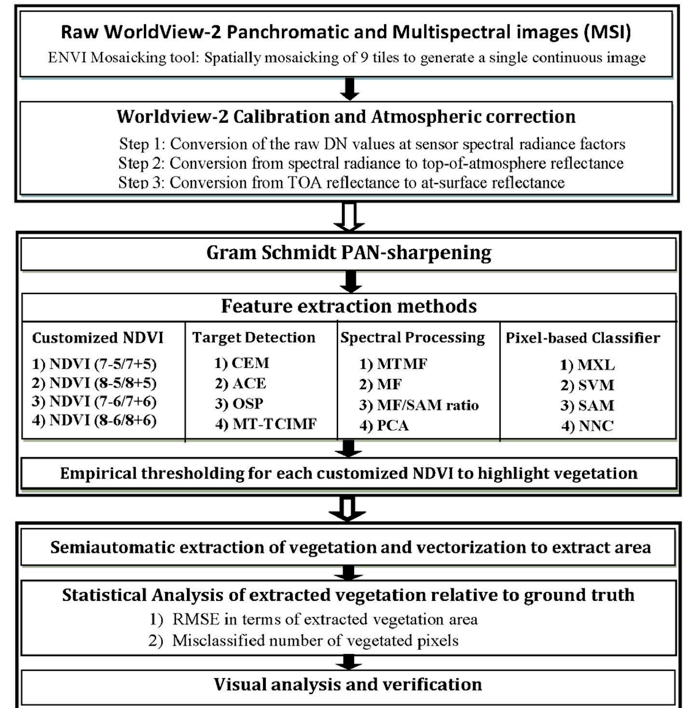
Figure 4. Methodology flowchart adapted for effective vegetation mapping in the cryospheric